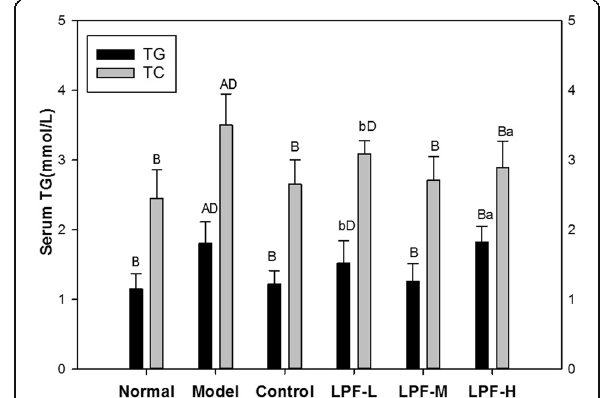
Fig. 4 Effects of LPF on serum TG and TC. The results were expressed as mean ± SD (n = 8/group). A p < 0.01, a p < 0.05, compared with normal group; B p < 0.01, b p < 0.05, compared with model group; D p < 0.01, d p < 0.05, compared with control group